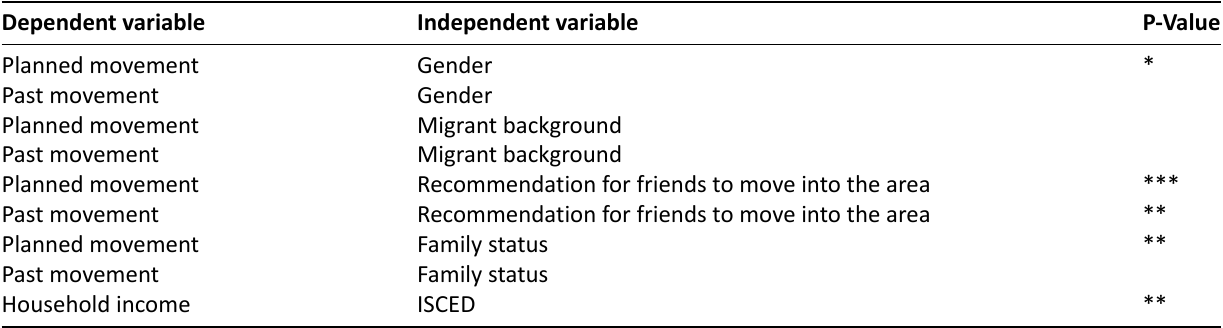
Table 3. Results of the χ 2 -test.